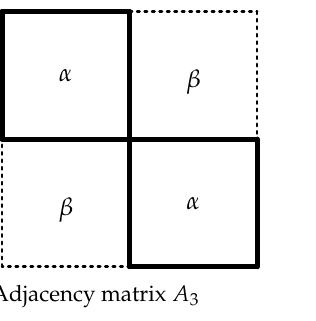
Figure 10. Benchmark graph. Model 3. Table 5. NMI. Model 3.